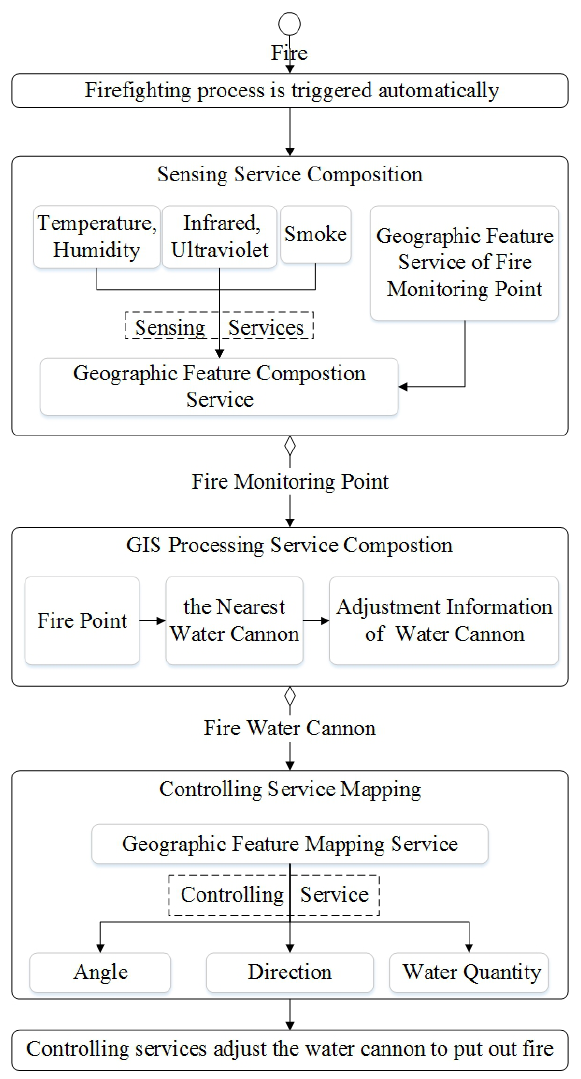
Figure 15. Automatic firefighting